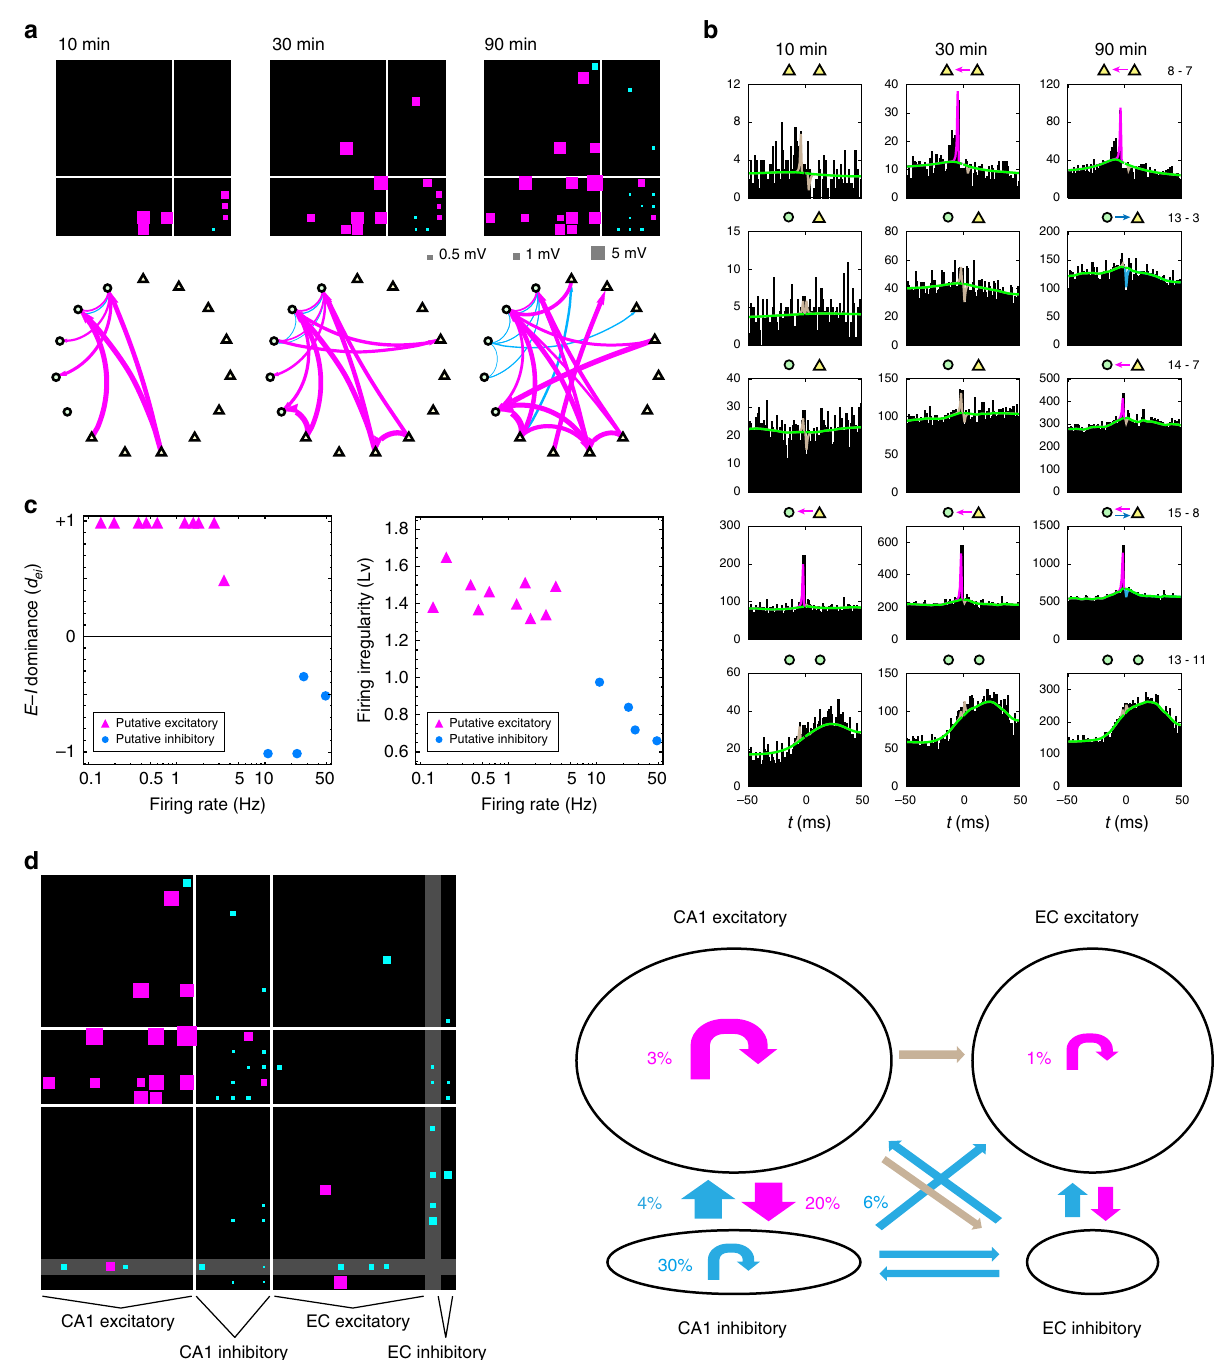
Fig. 5 Neuronal circuits reconstructed from real spike trains in vivo. a Neuronal connections estimated from spike trains recorded from the hippocampal CA1 area of a rat. Estimations were made with observation time windows of 600, 1800, and 5400 s (10, 30, and 90 min) for neurons whose fi ring rate is > 0 : 5 [Hz]. In each connection matrix, the x -axis indicates reference neurons. The connection matrix is partitioned into groups of putative excitatory and inhibitory neurons de fi ned manually according to other physiological cues such as waveforms. b Cross-correlations of several pairs of neurons computed at different time windows. The slow part of the GLM adapted to the data is depicted as a light green line. The coupling fi lter is separately depicted in magenta, cyan, or gray, for the excitatory, inhibitory, or undetermined, respectively. Corroborated connections are indicated by arrows. c E – I dominance index ( d and fi ring irregularity ( Lv ) are plotted against the fi ring rates for putative excitatory and inhibitory neurons. Neurons with > 1 connection with fi ring rate and > 0 : 1 [Hz] are plotted in the E – I dominance index. d Estimated connections among neurons in CA1 and Entorhinal Cortex (EC). The connection matrix is partitioned into putative excitatory and inhibitory neurons in CA1 and EC. One EC unit, whose excitatory or inhibitory characteristic was not determined by the manual analysis, is put in the gap (gray) between excitatory and inhibitory groups. In the network graph shown in the second panel, excitatory- and inhibitory-dominated connections are depicted in magenta and cyan, while connections of mixed characteristics are depicted in gray. Source data